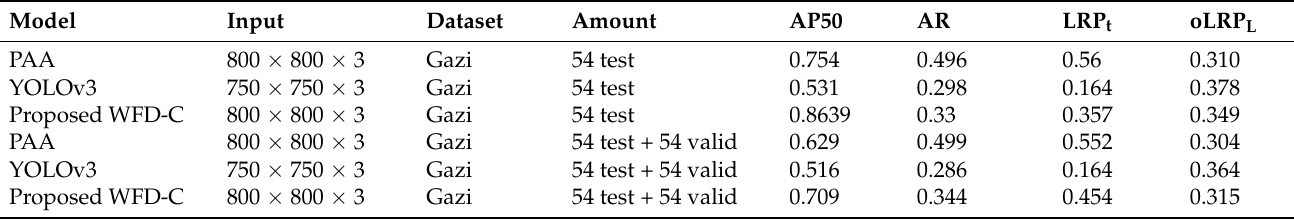
Table 11. Comparison with various amounts of wrist test